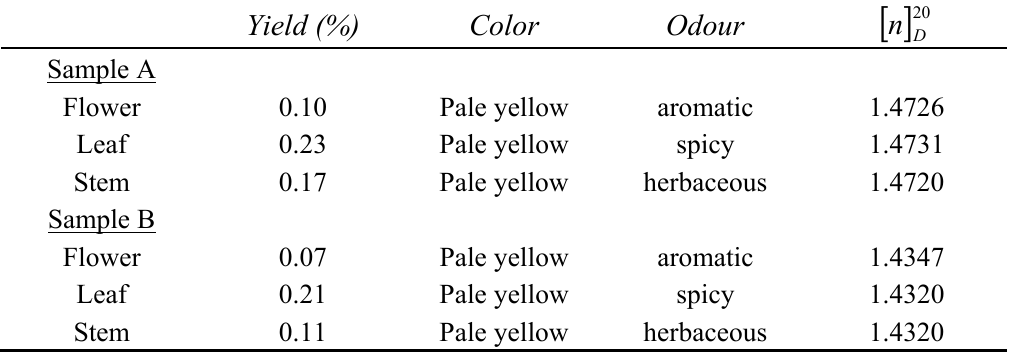
Table 1 . Physical properties of essential oils of Senecio polyanthemoides from two different